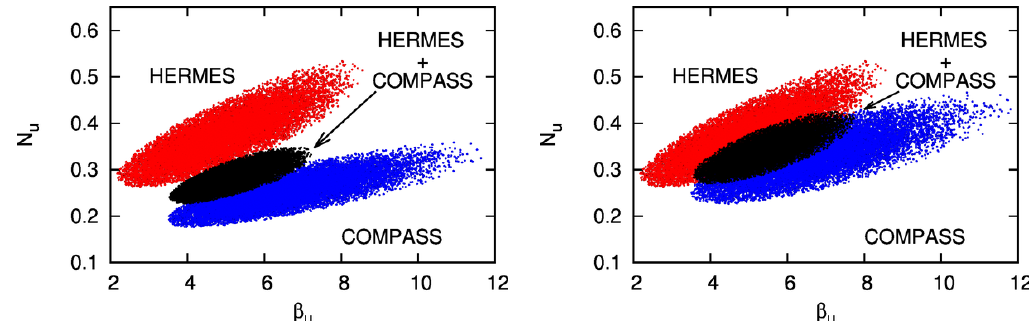
Figure 1 . Compatibility tests on (cid:25) + production from a proton target using only the u -contribution (all others (cid:13)avours being set to zero) of the Sivers function, as described in the text. In each panel, we show the scatter plot of the allowed values of (cid:12) u and N u , corresponding to a 2 (cid:27) C.L., for three cases: HERMES data (red), COMPASS data (blue), HERMES+COMPASS(black). Left panel: same unpolarized widths ( h k 2 i = 0 : 57 GeV 2 and h p 2 i = 0 : 12 GeV 2 as obtained from HERMES ? ? multiplicities). Right panel: di(cid:11)erent unpolarized widths for each experiment ( h k 2 i = 0 : 57 GeV 2 ? and h p 2 i = 0 : 12 GeV 2 for HERMES data, h k 2 i = 0 : 60 GeV 2 and h p 2 i = 0 : 20 GeV 2 for COM- ? ? ? PASS